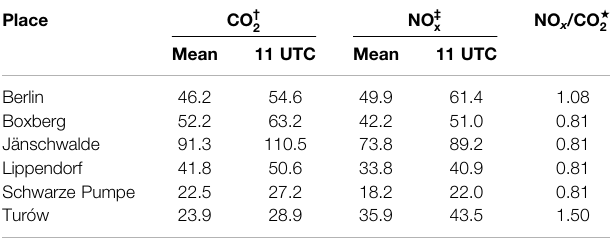
TABLE 1 | Summary of the emissions used in the SMARTCARB dataset.